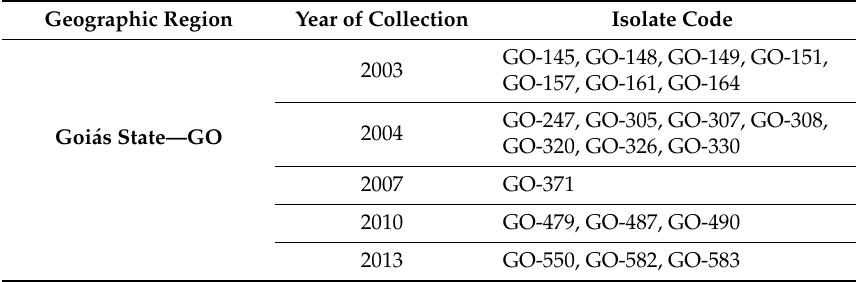
Table 2. Identification of 43 samples ( = isolates) exhibiting begomovirus-like symptoms that were obtained from tomato plants harboring the Ty -1 gene / locus in central Brazil. Information is provided about the region where the isolate was collected, year of collection, and the respective isolate